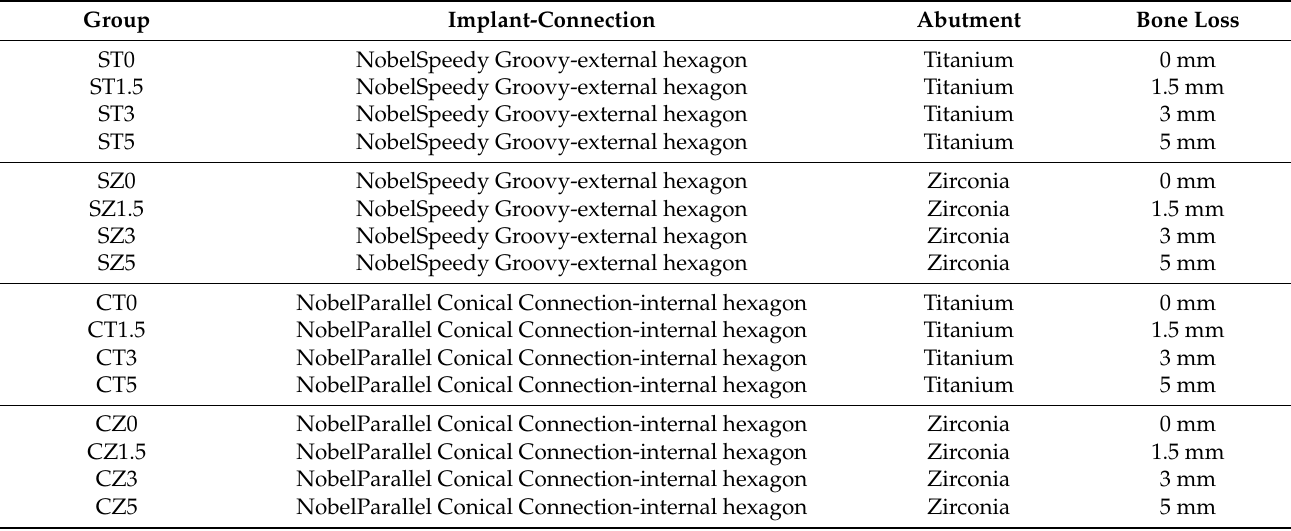
Figure 3. C groups with 0 mm (CT0 and CZ0), 1.5 mm (CT1.5 and CZ1.5), 3 mm (CT3 and CZ3), and 5 mm (CT5 and CZ5) bone loss. Table 1. Characteristics of the 16 models in the 4 groups.